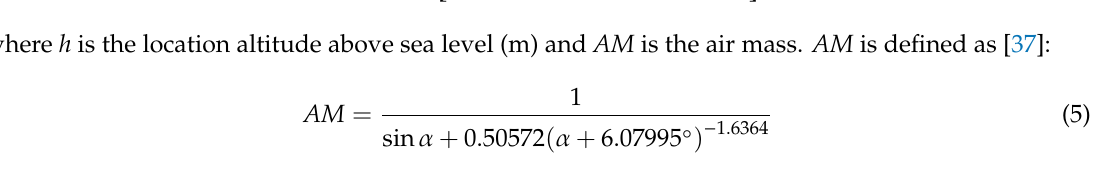
Table 4. Annual DNIs of different locations.